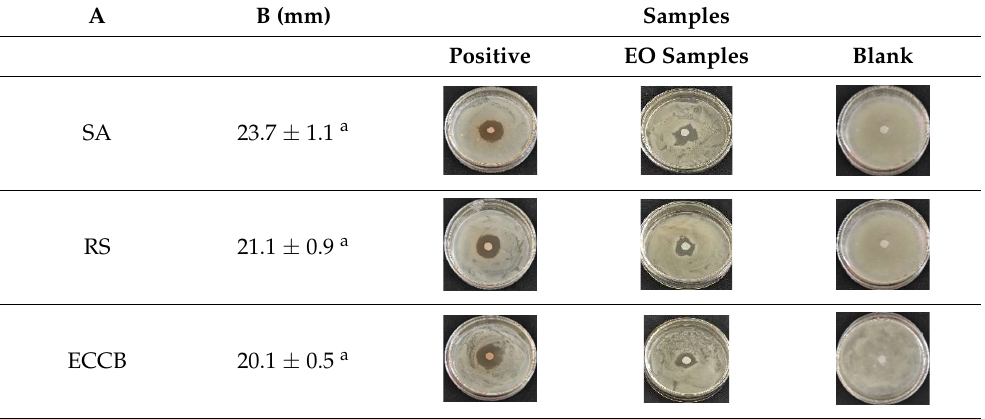
Table 4. Inhibition of EO on different species of bacteria.